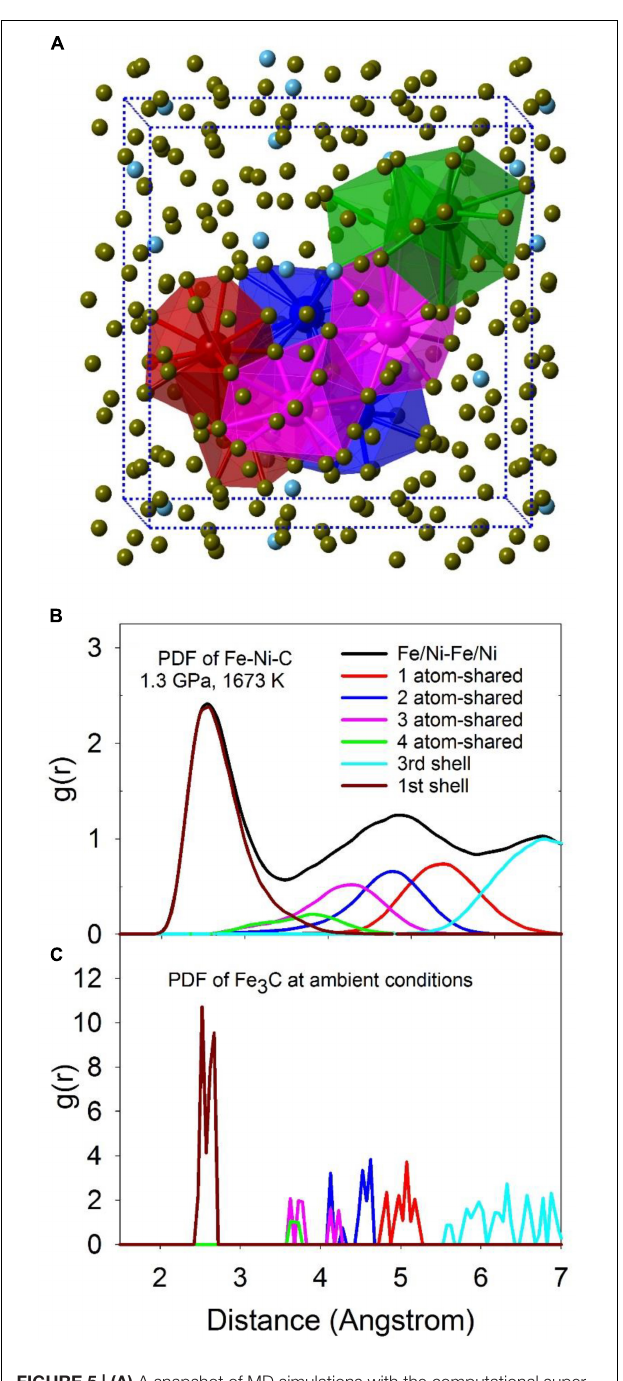
FIGURE 5 | (A) A snapshot of MD simulations with the computational super cell highlighted in dashed lines. The two highlighted polyhedra for each type are 1-atom corner-shared (red), 2-atom edge-shared (blue), 3-atom face-shared (magenta), and 4-atom distorted face-shared (green) polyhedra of Fe/Ni atom. The center atoms in the polyhedra are Fe/Ni atoms, with their sizes enlarged for clarity. (B,C) The total PDF (black) and partial configurationally decomposed PDFs of Fe/Ni-Fe/Ni with different connection schemes: 1-atom corner-shared (red), 2-atom edge-shared (blue), 3-atom face-shared (magenta), and 4-atom distorted face-shared (green) connections. (B) Fe-Ni-C liquid at 1.3 GPa, 1673 K (Lai et al., 2017). (C) Fe 3 C at ambient